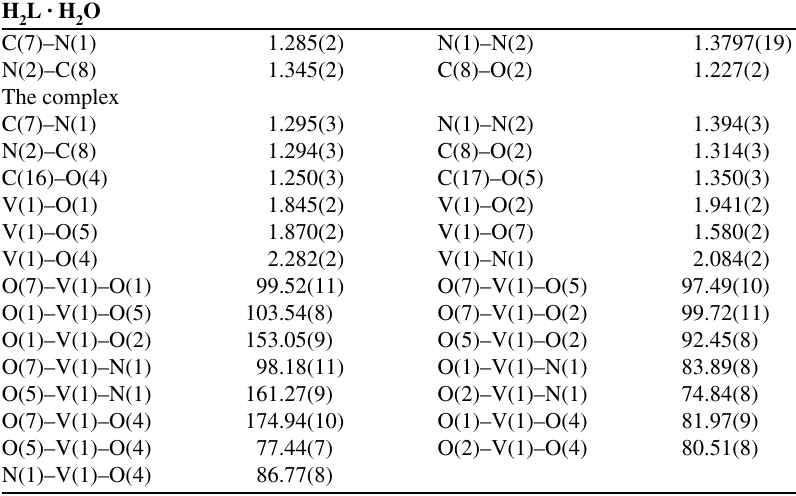
L · H O and the complex 2 2